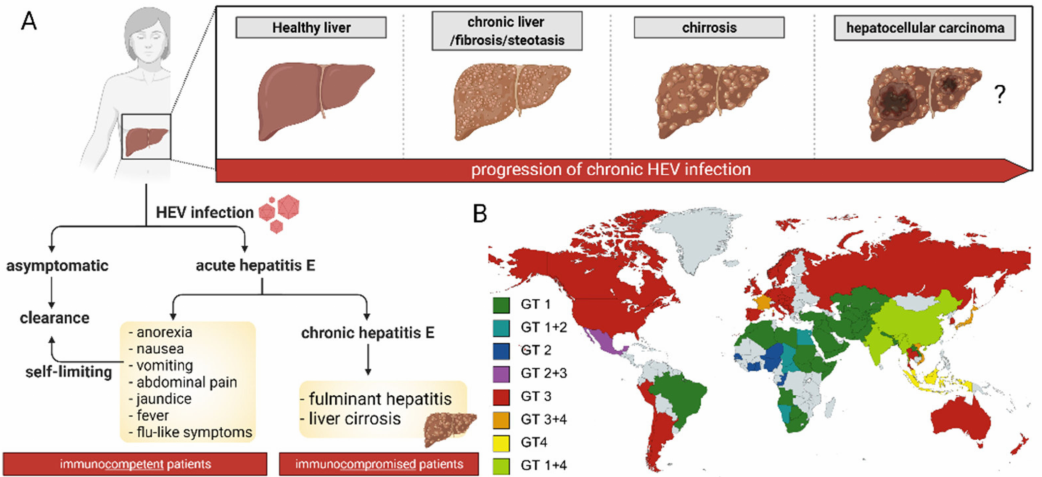
Figure 1. HEV clinical pathology and genotype distribution. ( A ) Progression of chronic HEV infection and clinical course of infection of immunocompetent and immunocompromised patients. ( B ) Geographical distribution of HEV GT1-4 infection. Different colors on the map indicate different HEV genotype (GT1-4) distributions across the globe based on Pallerla et al. [28]. Image was created using BioRender ( A ) and MapChart ( B